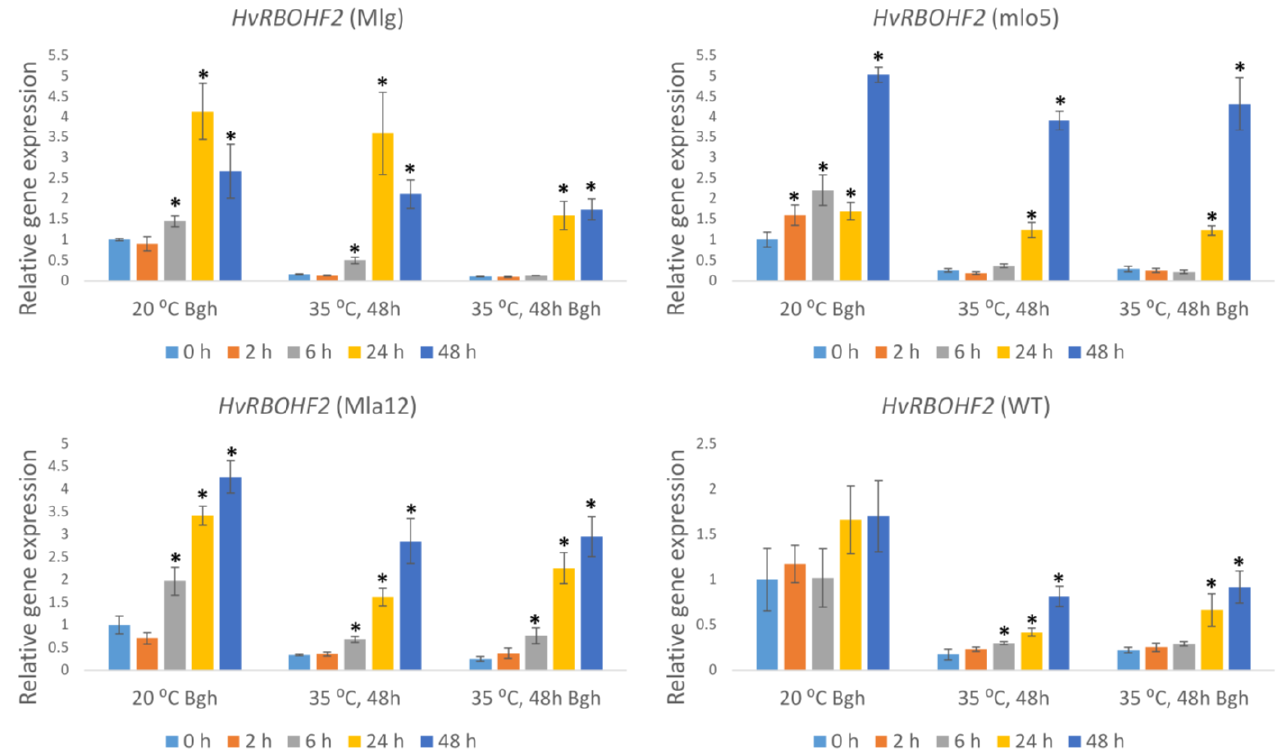
Figure 6. Expression of the barley Respiratory burst oxidase homologue F2 ( HvRBOHF2 ) gene as detected by RT-qPCR in resistant (Mlg, mlo5, Mla12) and susceptible (WT) Hordeum vulgare cv. Ingrid near-isogenic lines at early time points (0 h, 2 h, 6 h, 24 h, and 48 h) following powdery mildew ( Blumeria graminis f. sp. hordei A6, Bgh) inoculation, and/or heat stress. Heat stress treatments at 35 °C for 48 h were applied immediately before Bgh inoculation. Inoculated but not heat-treated (20 °C Bgh) and heat-treated but not inoculated (35 °C for 48 h) plants were used as controls. The graphs show the average of three experiments. Error bars represent standard deviation. Asterisks ( * ) indicate statistically significant differences from 0 h for each specific treatment at p < 0.05.